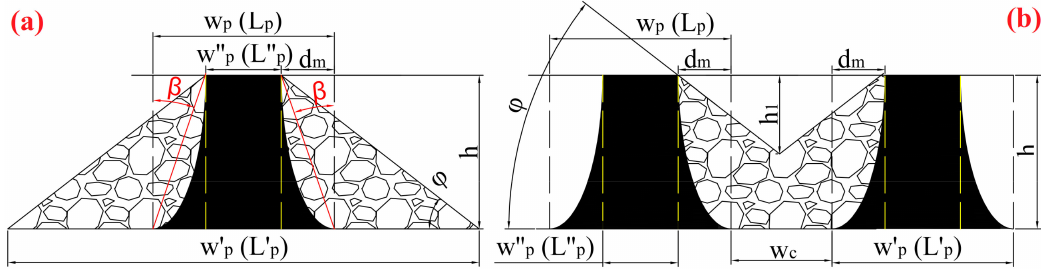
Figure 2. The diagram of pillar peeling for ( a ) an isolated pillar and ( b ) non-isolated